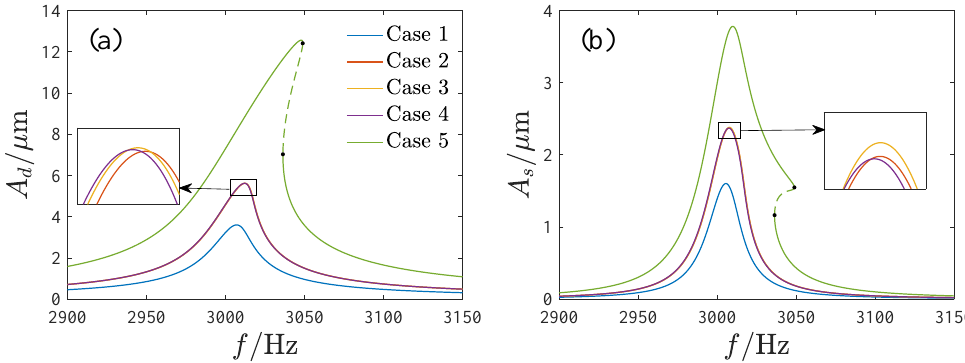
Figure 16. The amplitude–frequency curves corresponding to different DC and AC voltages, Case 1 V D = V A = 8 V, Case 2 V D = V A = 10 V, Case 3 V D = 5 V = V A = 20 V, Case 4 V D = 20 V = V A = 5 V, Case 5 V D = V A = 15 V. ( a ) The amplitude–frequency curves of the driving direction, ( b ) The amplitude–frequency curves of the sensing direction.